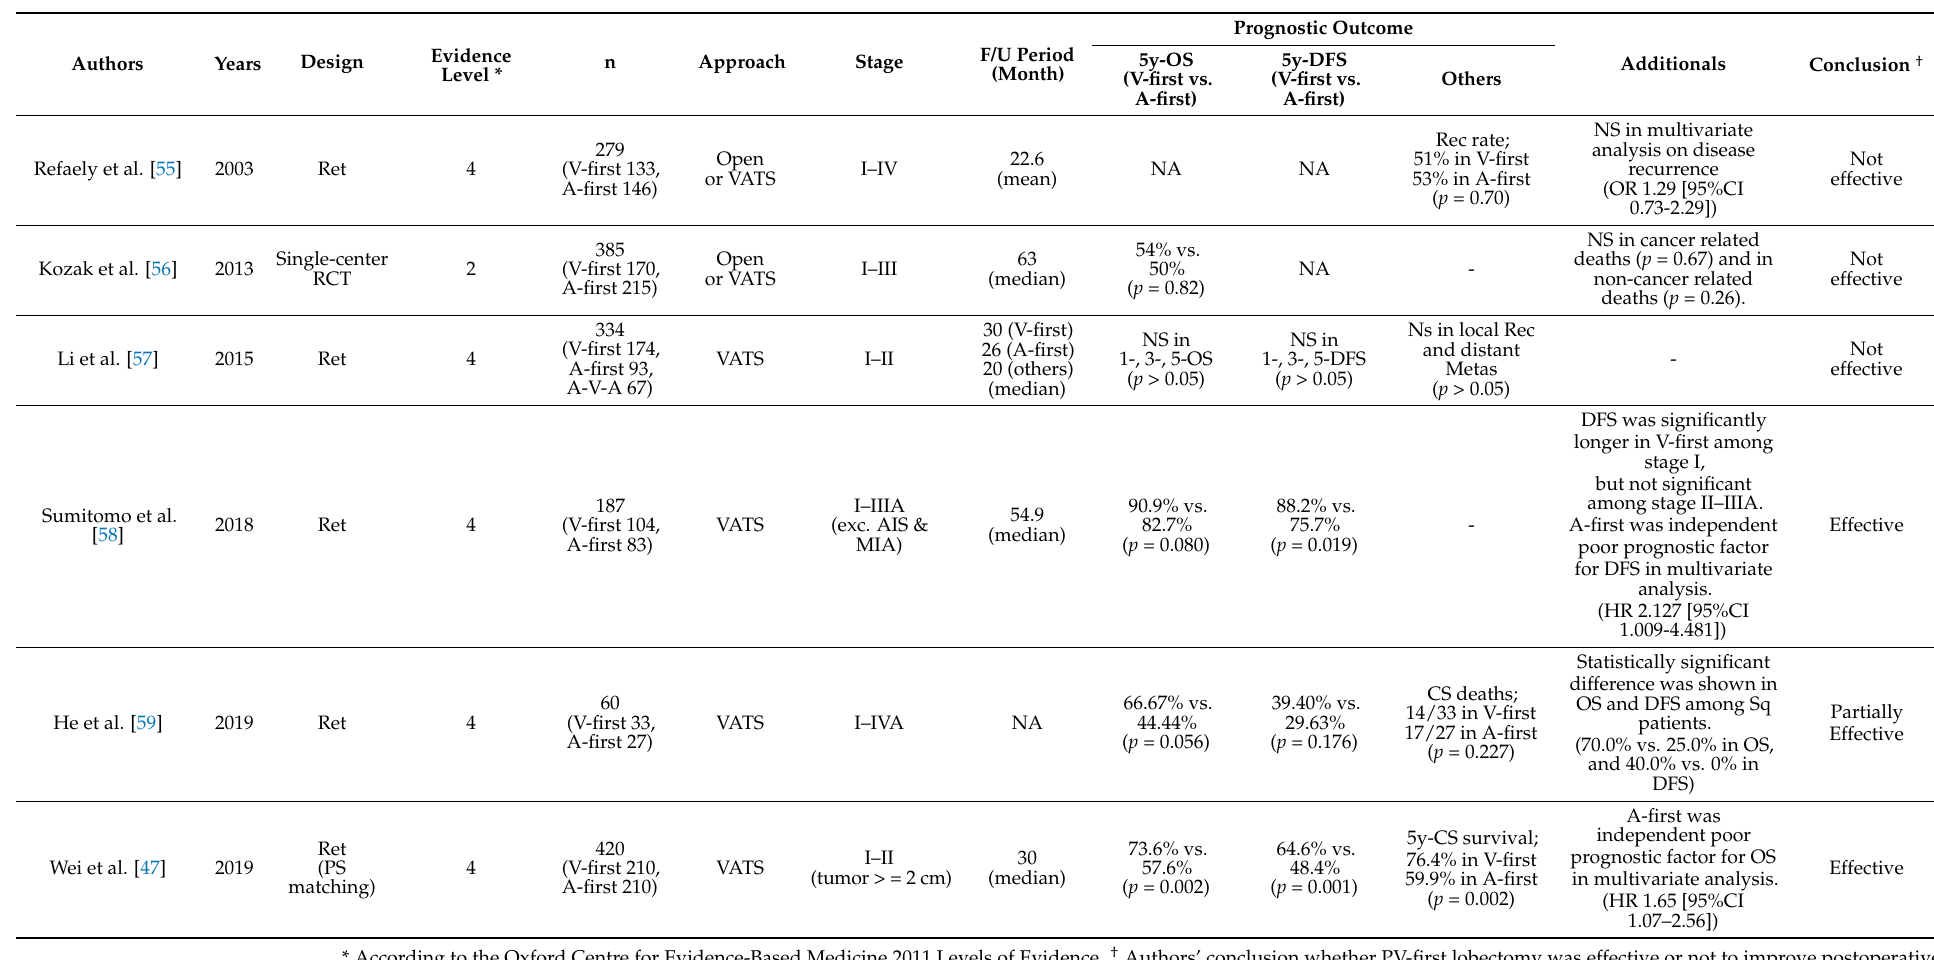
Table 3. Summary of studies researching relation between PV-first technique and postoperative prognosis in non-small-cell lung